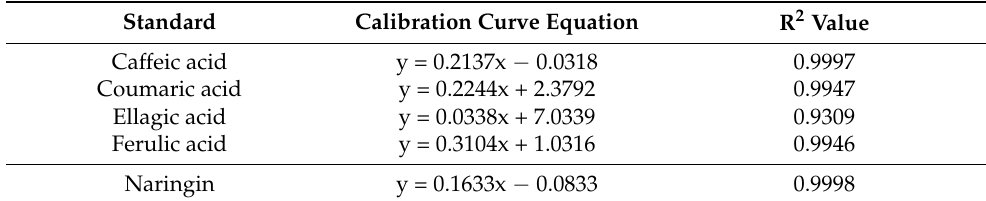
Table 7. Equations of calibration curves for individual polyphenolic